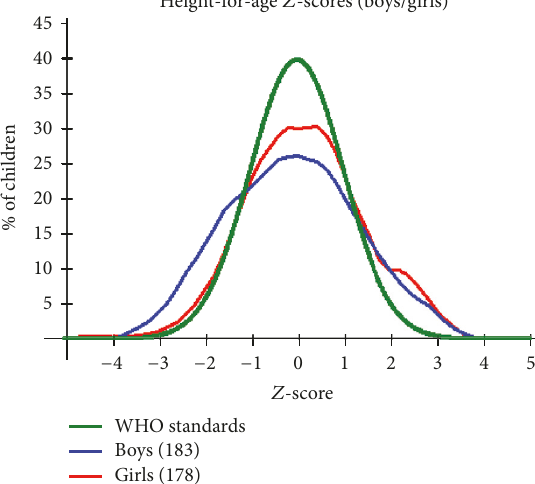
Figure 1: A plot of weight for height 𝑍 -scores by gender for the PSAC in Mwea Division against the recommended WHO standards.